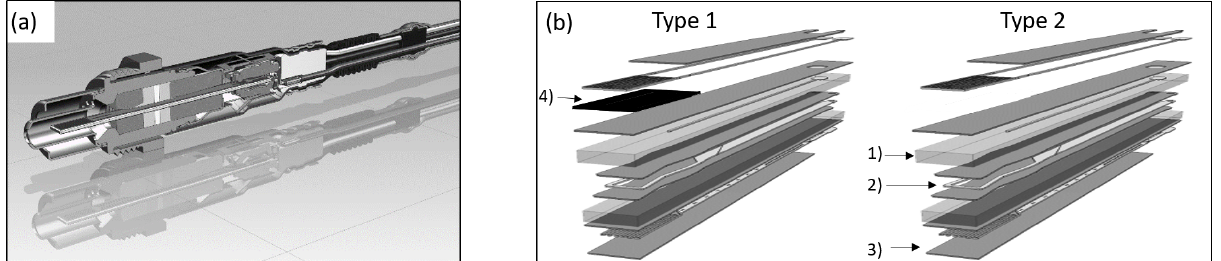
Figure 1. (a) Cross section of a Bosch PM2.2 sensor. (b) Enlarged views of sensor element types 1 and 2. Materials from light to dark gray: